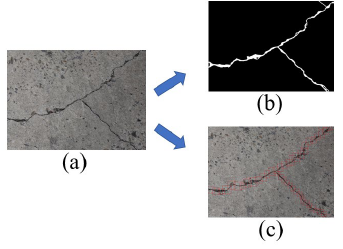
Figure 2. Methods for annotation: (a) the original crack, (b) pixel-level annotation, and (c) bounding box annotation. The next step is to separate the dataset for different purposes. The suggested division are 70% for training, 20% for validating, and